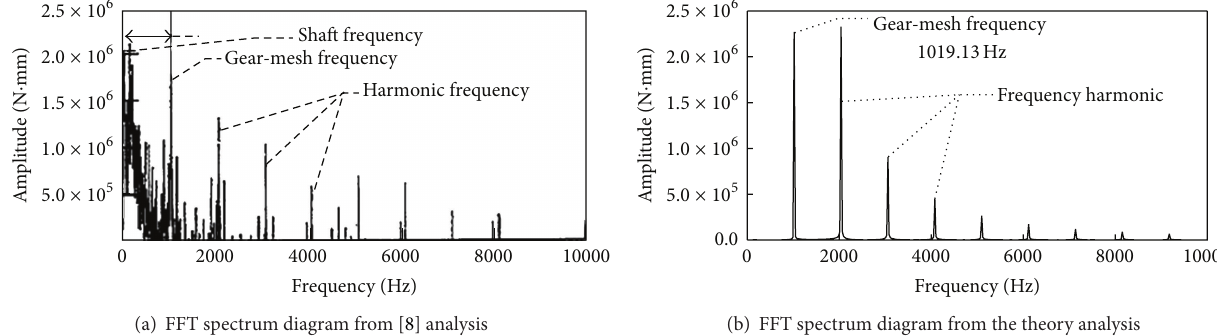
(b) FFT spectrum diagram from the theory analysis Figure 19: FFT spectrum of dynamic load contrast between theory analysis and [8]